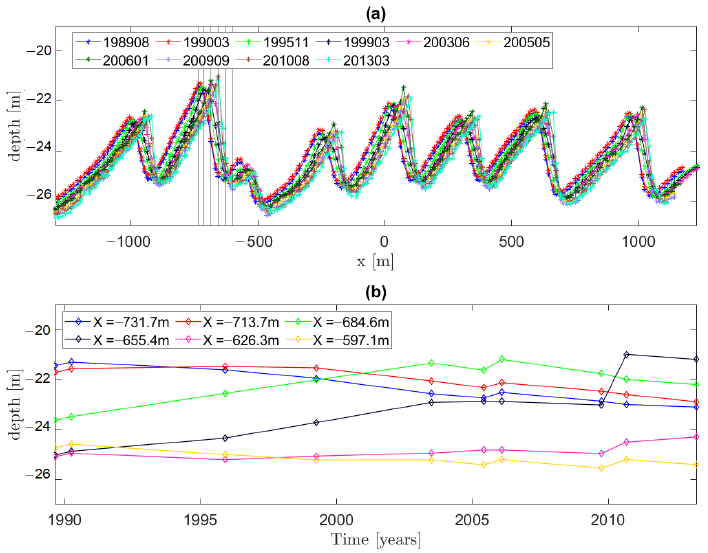
Figure 13. Example of temporal change in sand wave feature. ( a ) Cross-sections for different epochs and ( b ) Nodal temporal trend of the observations for different x-locations shown by the vertical, black lines in ( a